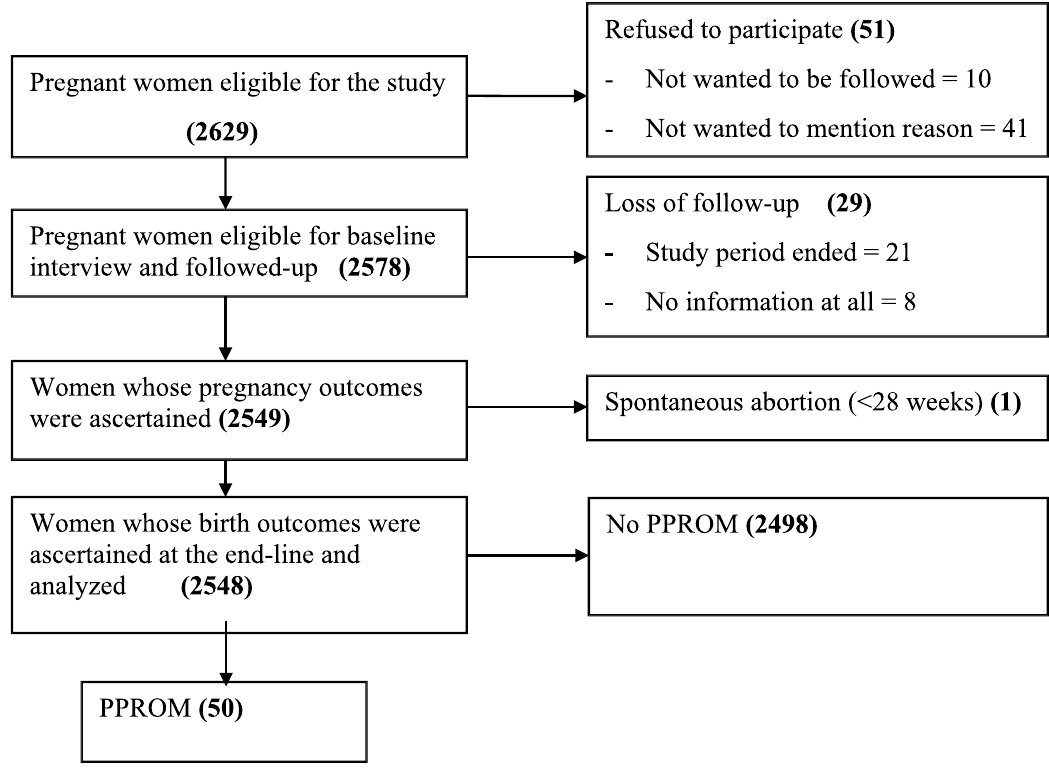
Figure 1. Flow-diagram of the overall study process at towns in Hadiya zone, South Ethiopia, July 2019– September